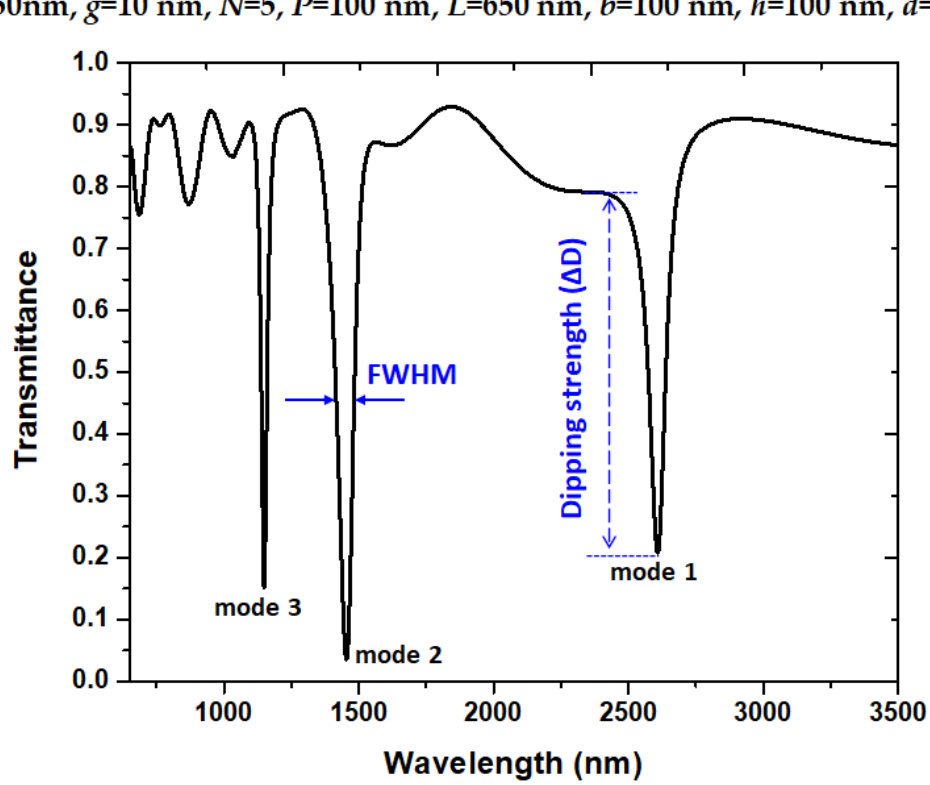
Figure 2. Transmittance spectrum for the designed structure without pressure on the system (i.e., d = 0 nm).